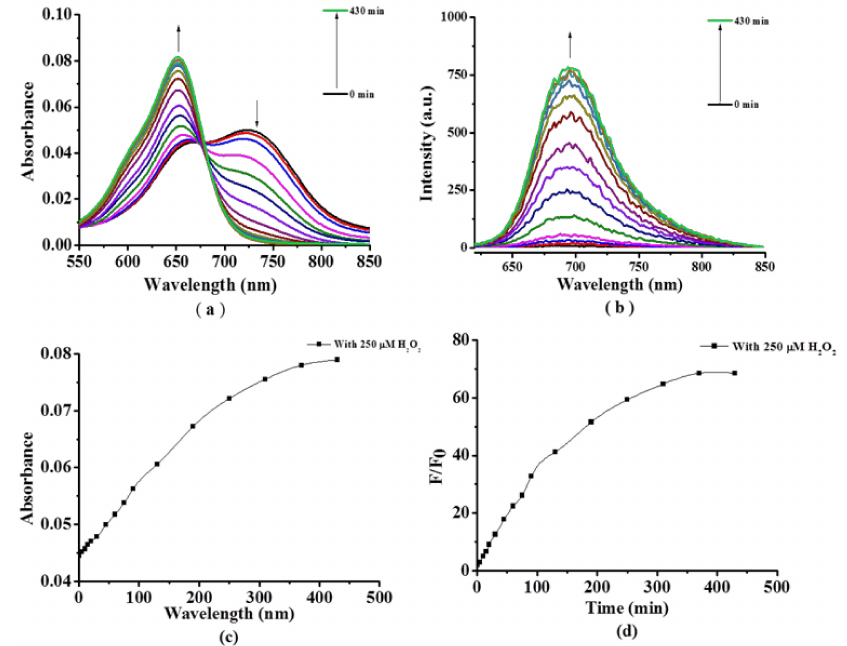
Figure 6. ( a ) Absorption and ( b ) fluorescence emission spectra for compound 7 (1 µ M) upon incubating with H 2 O 2 (250 µ M) for varying time intervals; the plots show the time-dependent increases ( c ) absorption at 653 nm and ( d ) fluorescence intensities at 678 nm; the experiments are carried out in solution (PBS/DMSO = 4:1, v / v ; 10 mM, pH =